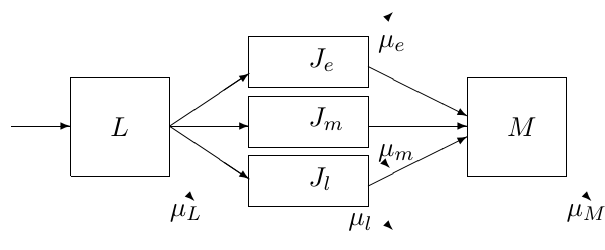
Fig. 1. Compartmental structure and flow chart The eggs hatch within two weeks after